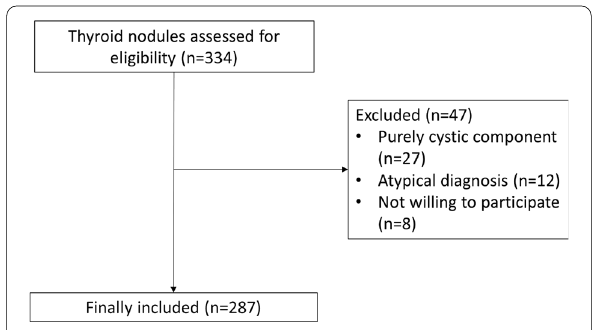
Table 2, distribution of benign and malignant thyroid nodules according to the three ultrasound classification systems has been indicated. Regarding ACR-TIRADS,